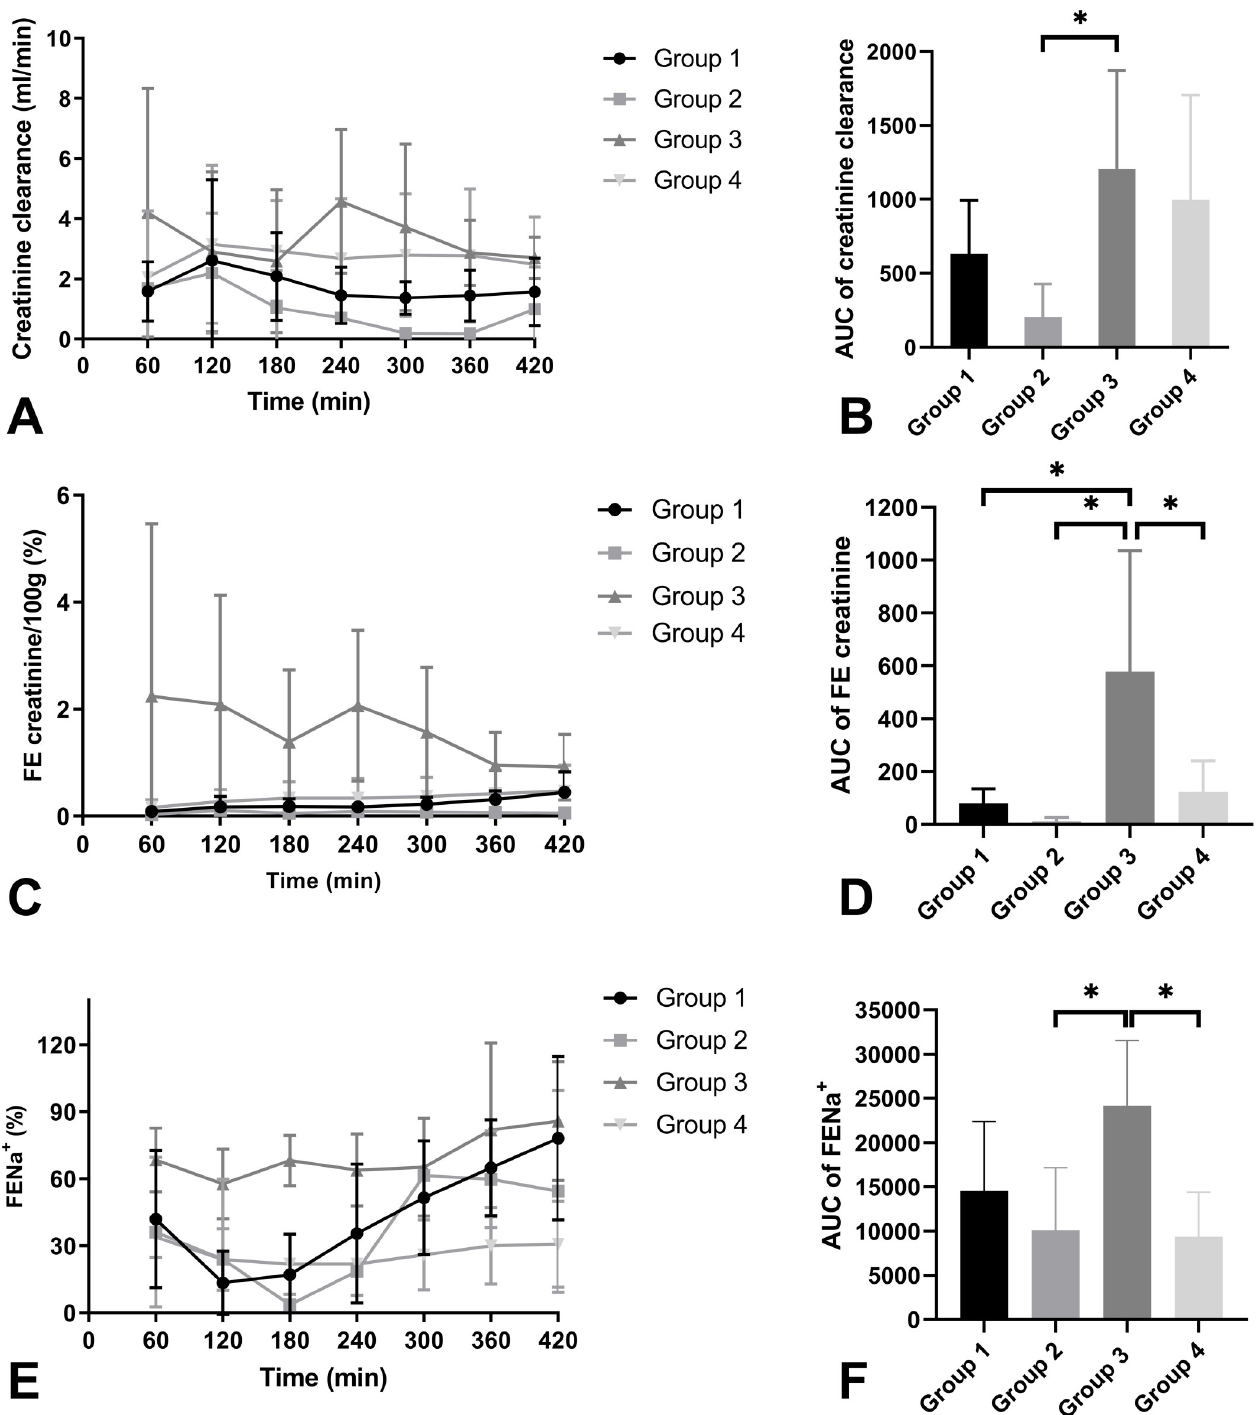
Fig 6. Mean creatinine clearance (ml/min) (A), AUC of creatinine clearance (B), mean fractional excretion of creatinine per 100g (FE creatinine/100g) (C), AUC of FE creatinine (D), mean fractional excretion of sodium (FENa + ) (E), and AUC of FENa + (F) of the four experimental groups during NMP (+ SD). � indicates a level of significance of p �